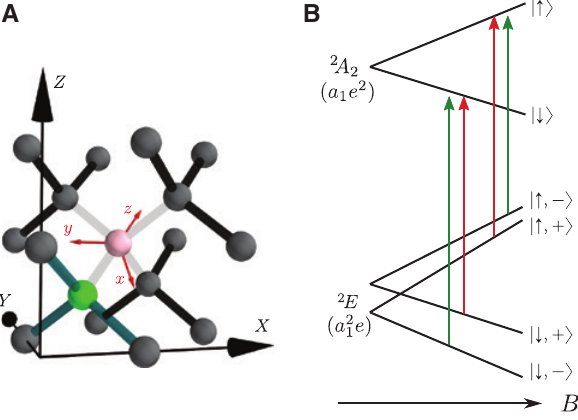
Figure 1: The atomic and electronic description of the NV 0 center. (A) Unit cell of diamond containing a nitrogen vacancy (NV) center with crystallographic coordinates ( X , Y , Z ) = ([100], [010], [100]) and NV coordinates chosen as ( x , y , z ) = ([112̅], [1̅10], [111]). The carbon atoms are depicted as gray, the nitrogen atom as green, and the vacancy site as pink. (B) Energy levels of the NV 0 ground 2 E ( a 2 ( ) a e states, where the brackets signify the molecular orbitals [14]. 1 The orbital states are denoted by + , − and spin states by ↑ , ↓ . Left and right circularly polarized optical transitions are denoted by the red and green arrows. The gradients of the ground state resonances with respect to magnetic field are unequal due to the orbital Zeeman competing with spin Zeeman